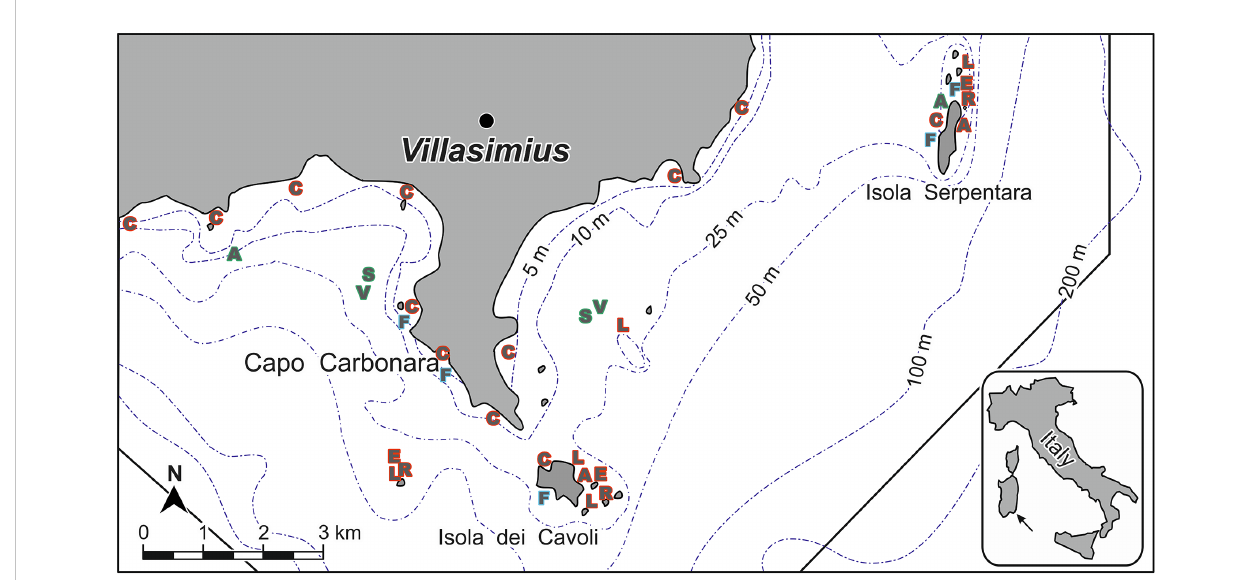
FIGURE 1 Survey sites within the study area. Colors refer to the different habitat/biotic components (blue: fi sh; red: reef; green: seagrass) for which indices provide information. Capital letters indicate the measured index: A (ALEX); C (CARLIT); E (ESCA); F (all three fi sh indices); L (LIMA); R (COARSE); S (SI); V